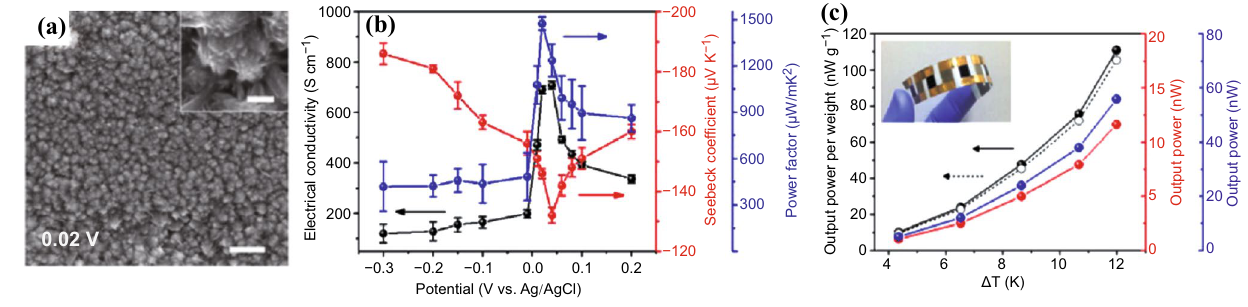
Fig. 6 a SEM image of electrodeposited Bi 2 Te 3 nanocrystals at a potential of 0.02 V (scale bar: 500 nm). b Corresponding σ (black circle), S (red circle), and PF (blue circle) of the flexible TE generators (FTEGs) with Bi 2 Te 3 films deposited at different potentials (V vs. Ag/AgCl). c Output power per weight of 1-couple (filled black circle) and 5-couples (open black circle) and output power of 1-couple (red circle) and 5-cou- ples (blue circle) of the pn-FTEGs over a temperature gradient (ΔT). Adapted with permission from Ref. [96]. (Color figure